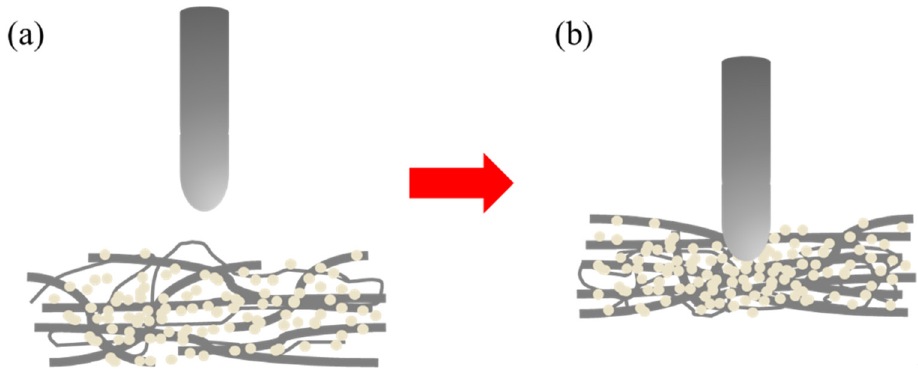
Figure 10. Illustrative diagram of STF composite nonwoven fabrics with ( a ) an even distribution before the test; ( b ) the collision of SiO 2 particulates during the test.